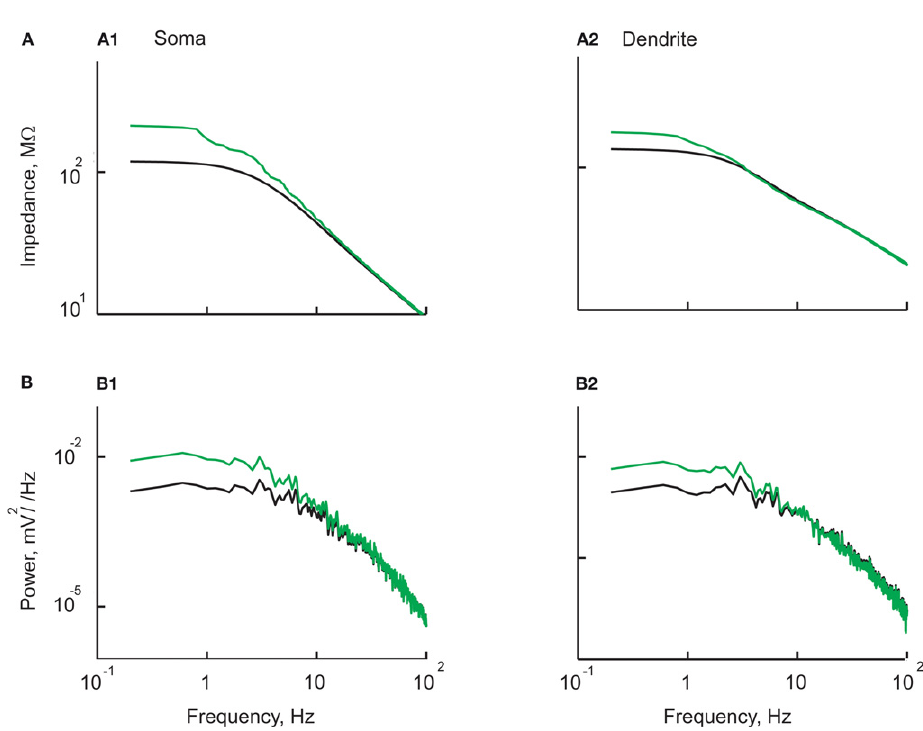
Figure 6 | The experimental dependence of impedance and voltage noise on the membrane potential can be accounted for by the presence of persist- ent sodium current near the soma. The impedance (A) and noise spectra (B) at the soma (left panels) and the dendrite (right panels). The results obtained with (green) and without (black) persistent Na + channels at the soma. Note the decrease in noise level and impedance at low frequencies without persistent Na + channels. (Compare with Figure